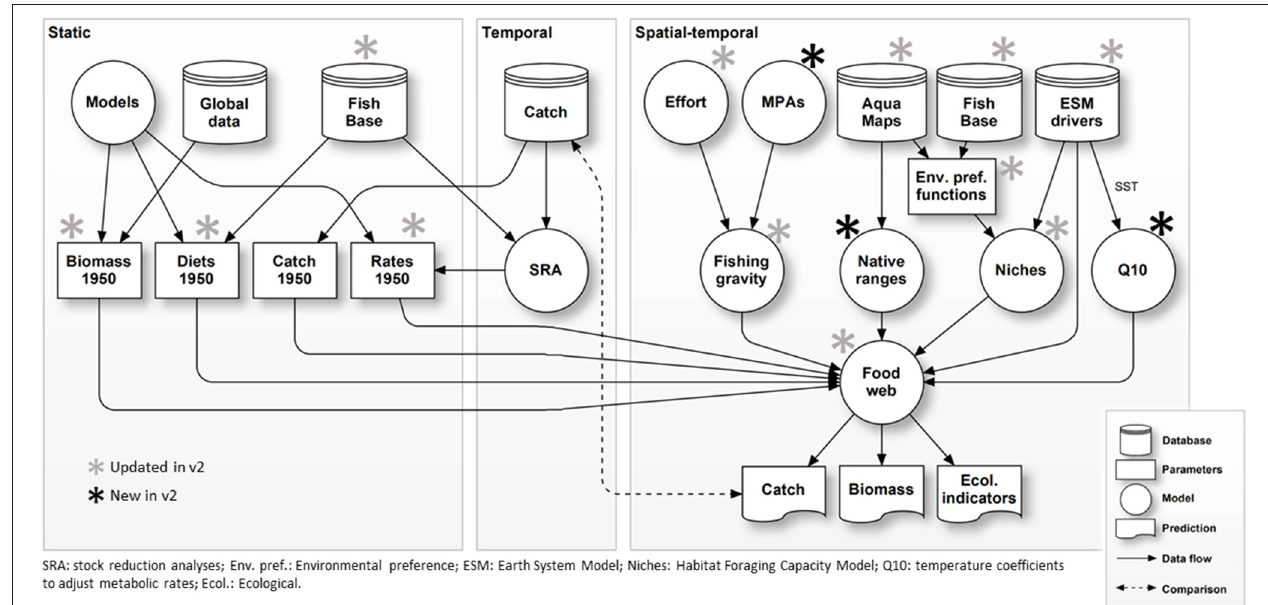
FIGURE 1 | Schematic structure of EcoOcean v2 modeling